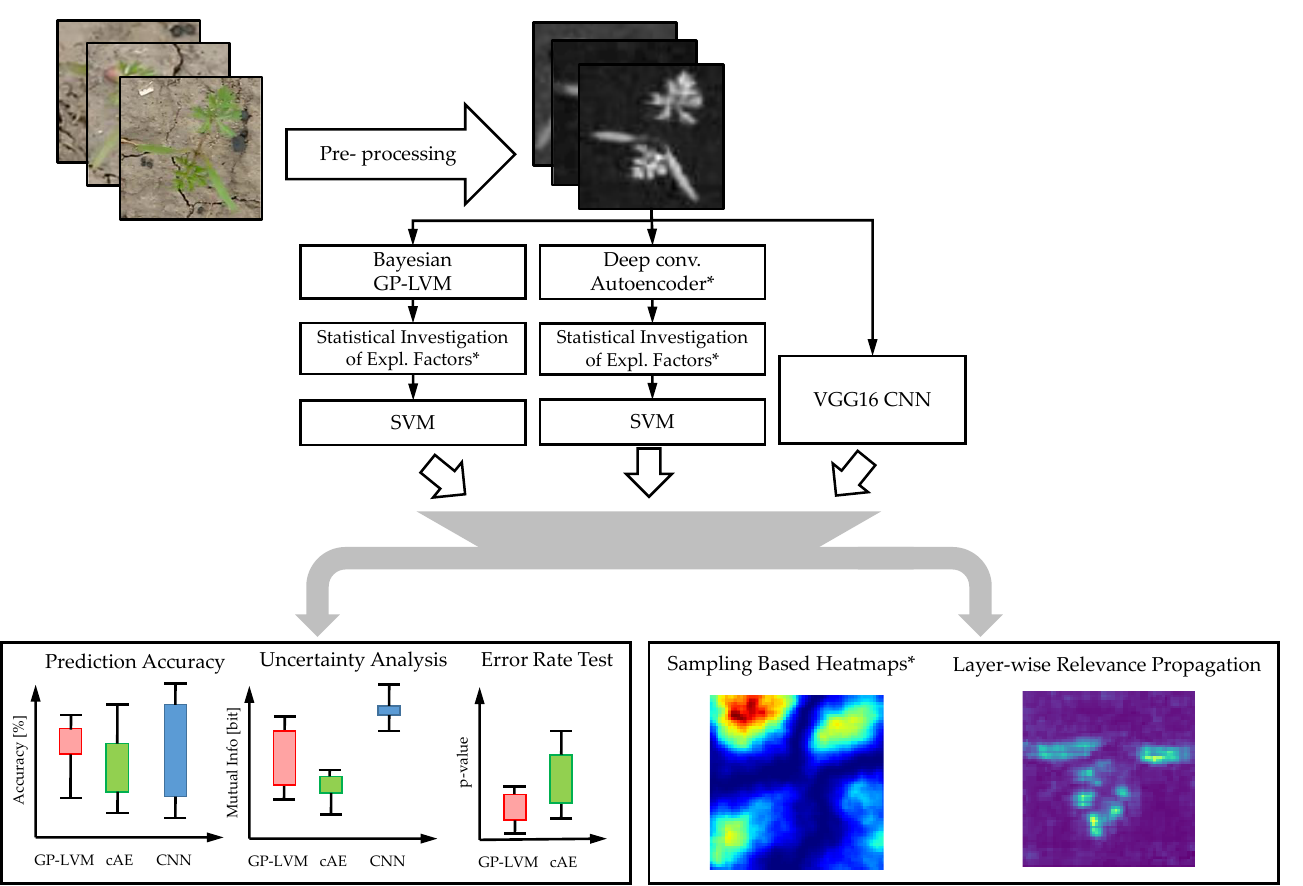
Figure 2. Data processing pipeline used in this study. The classification task is implemented using three different approaches. The results are analyzed and compared. The objective of our study is the evaluation of the explanatory factors of machine learning models. To this end, we compare the VGG16 CNN [33] to a Bayesian GP-LVM [39] and deep convolutional autoencoder [35] based classification methodology. We compare the models using statistical analysis metrics relying on the prediction accuracy, mutual information, and McNemars test for error rates. Finally, the explanatory factors are visualized using layer-wise relevance propagation [26] and the sampling method of [29,37]. The contribution of this study is